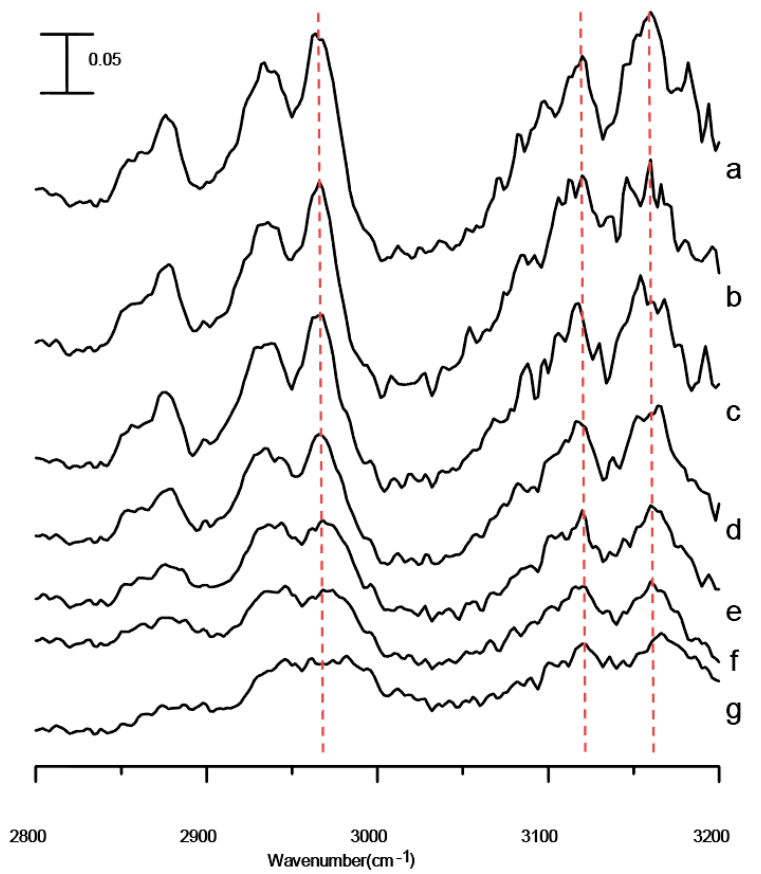
Figure 5. IR spectra of the mixture after five washes with ethanol obtained under ambient pressure (curve a) and at 0.4 (curve b), 0.7 (curve c), 1.1 (curve d), 1.5 (curve e), 1.8 (curve f), and 2.5 GPa (curve g). All curves were baseline-corrected by subtracting straight lines. Relative intensities of the IR bands are given in increments of 0.05; the scale bar is displayed in the upper left corner of the figure.